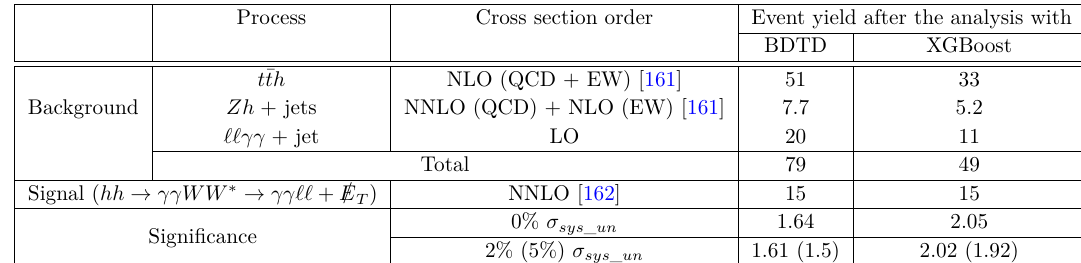
Process Cross section order Event yield after the analysis with BDTD XGBoost